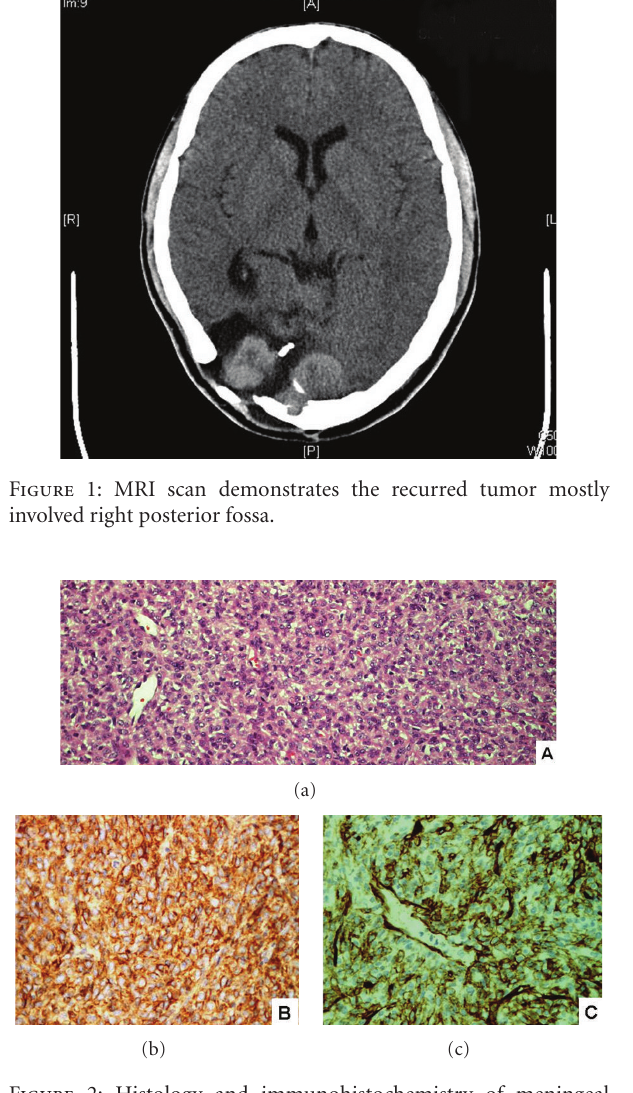
Figure 2: Histology and immunohistochemistry of meningeal hemangiopericytoma. (a) H&E 20x A hypercellular tumor with staghorn blood vessels. (b) Immunostaining of CD99 is di ff use and strong positive. (c) Immunostaining of CD 34 reveals variable positive.